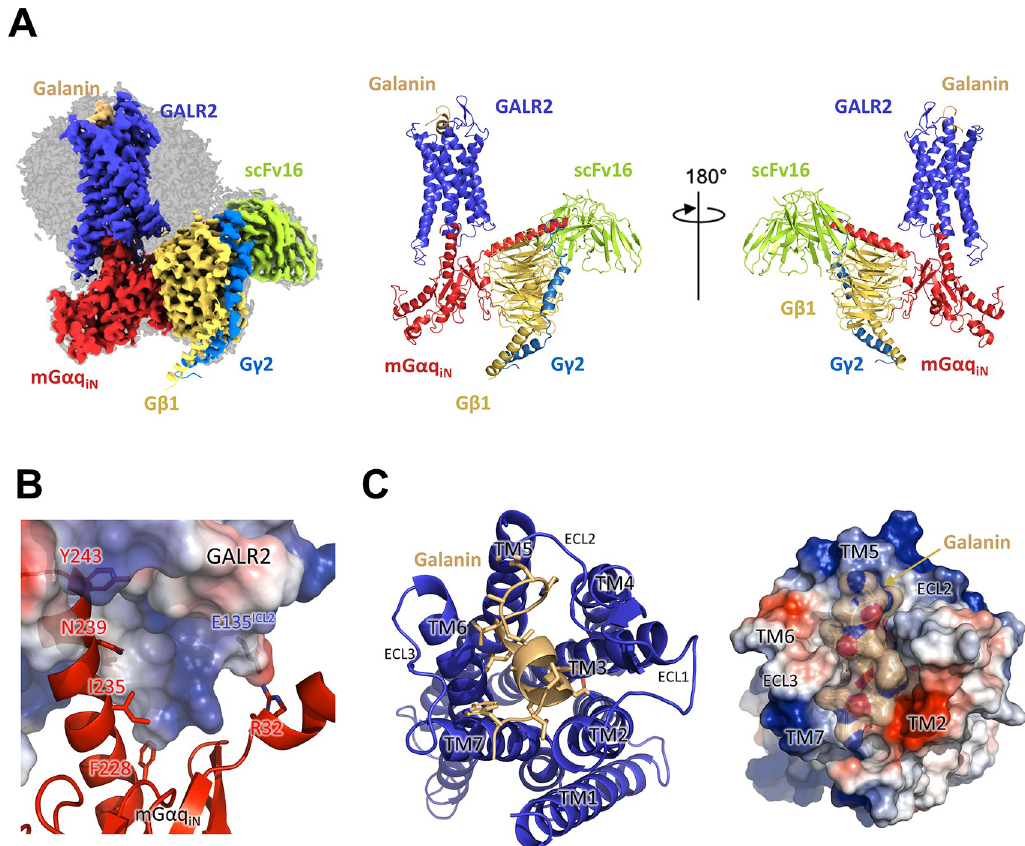
Fig 1. Cryo-EM structure of GALR2 complex with galanin. (A) The molecular structure of GALR2 complex is shown both as cryo-EM map and ribbon diagram. GALR2, mG α q iN , G β 1, G γ 2, and scFv16 are colored in blue, red, yellow-orange, marine, and lemon, respectively. The bound galanin peptide is colored in light orange. (B) The C-terminal helix of mG α q iN is inserted in the pocket formed by TM5–7 of GALR2 forming hydrophobic and hydrophilic interactions. Arg32 of mG α q iN forms a salt bridge with Glu135 ICL2 of GALR2. (C) The galanin is bound to the pocket formed among the 7 TMs of GALR2 at the extracellular side (left panel). GALR2 and galanin are shown as an electrostatic surface representation (right panel). cryo-EM, cryo-electron microscopy; TM,